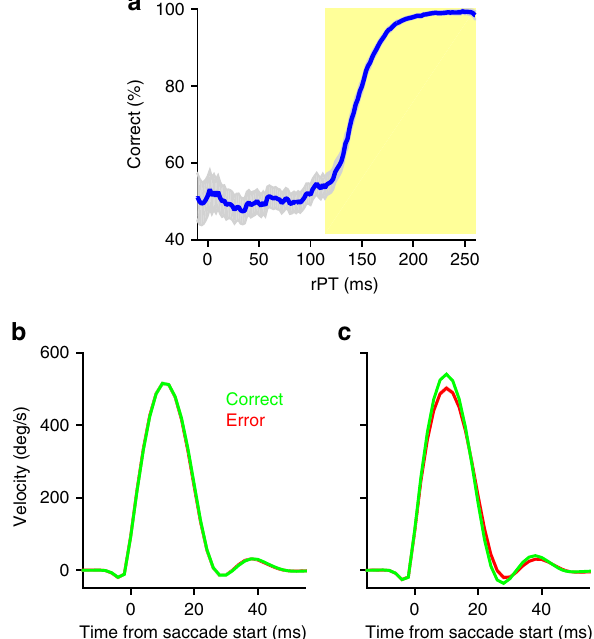
Fig. 2 Eye velocity pro fi les show evidence of a perceptual in fl uence on saccade kinematics. a Tachometric curve (blue). Trials were divided into two rPT ranges — short (white region) and long (yellow region) — according to the tachometric curve. Error bars represent 95% binomial proportion con fi dence intervals. b , c Mean eye velocity (±1 standard error of the mean; s.e.m.) of correct (green) and incorrect (red) saccadic choices executed at short ( b ) and long ( c ) rPTs. Velocity traces are plotted as functions of time from saccade onset. Data are from monkey